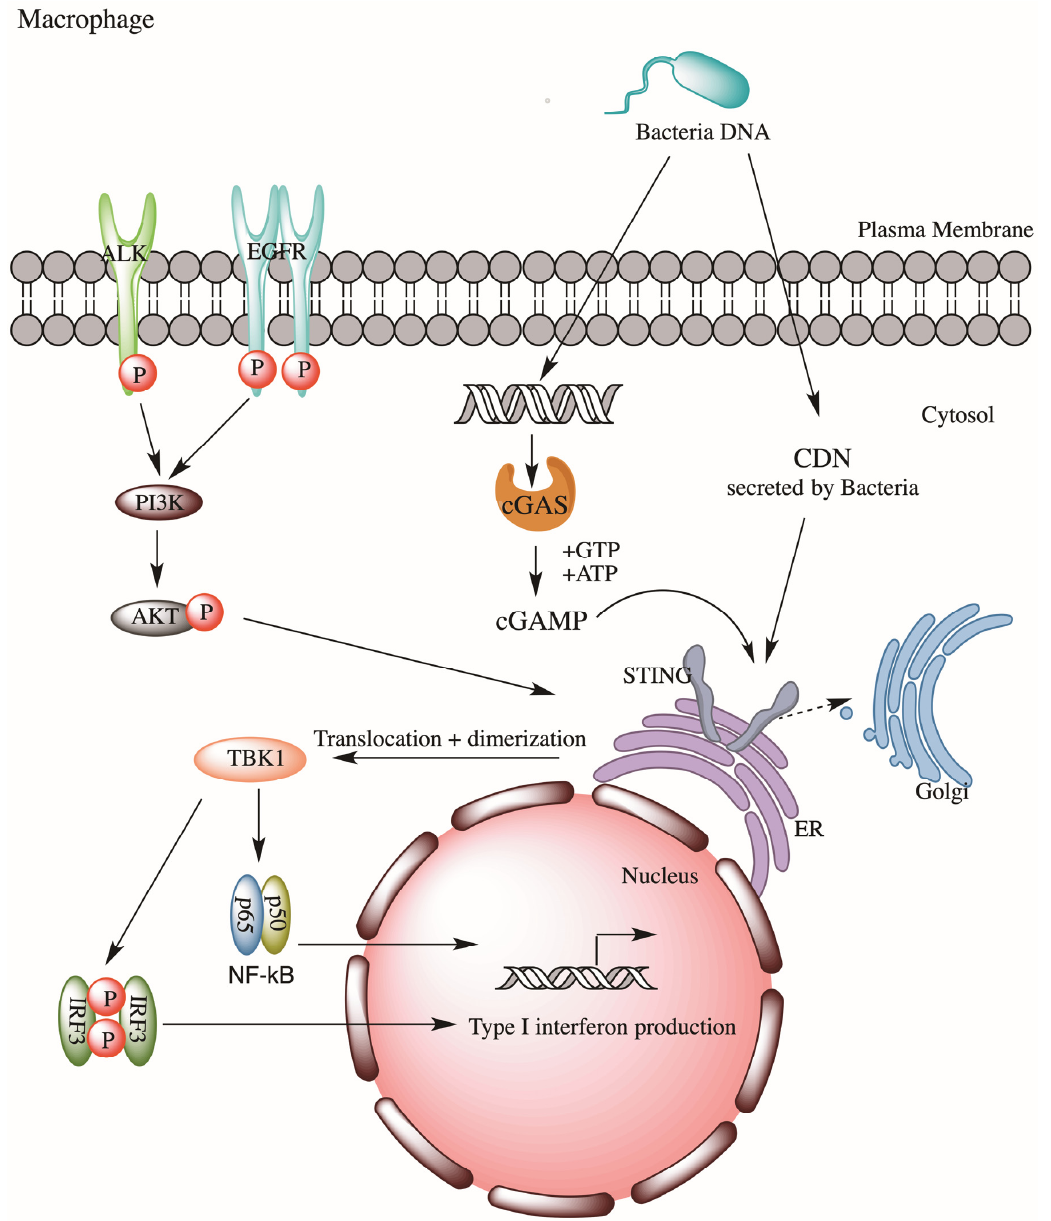
Figure 2. ALK-EGFR-AKT pathway promote STING-dependent innate immune response in macrophage during bacterial sepsis.